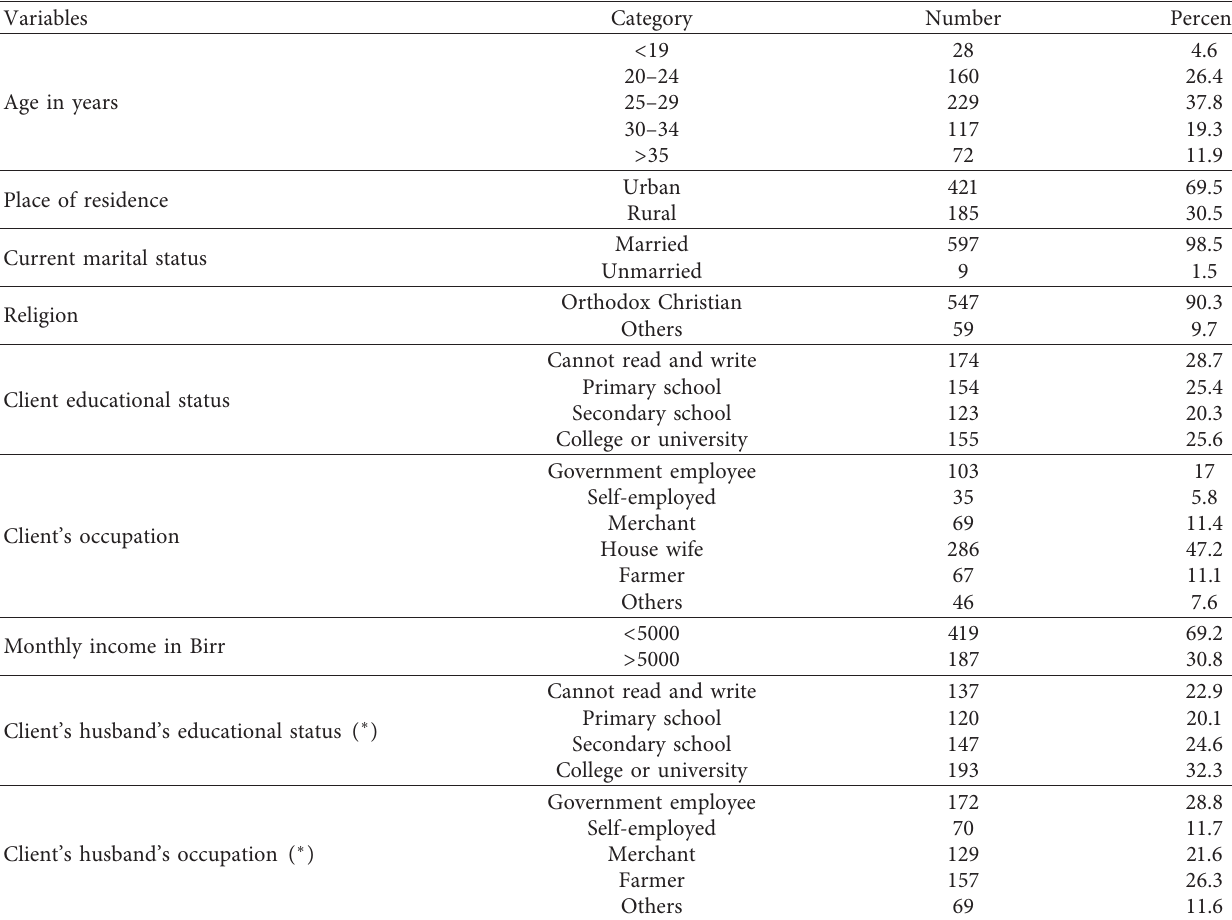
Table 1: Sociodemographic characteristics of study participants in Felege Hiwot Referral Hospital from June–August 2018 ( n � 606).